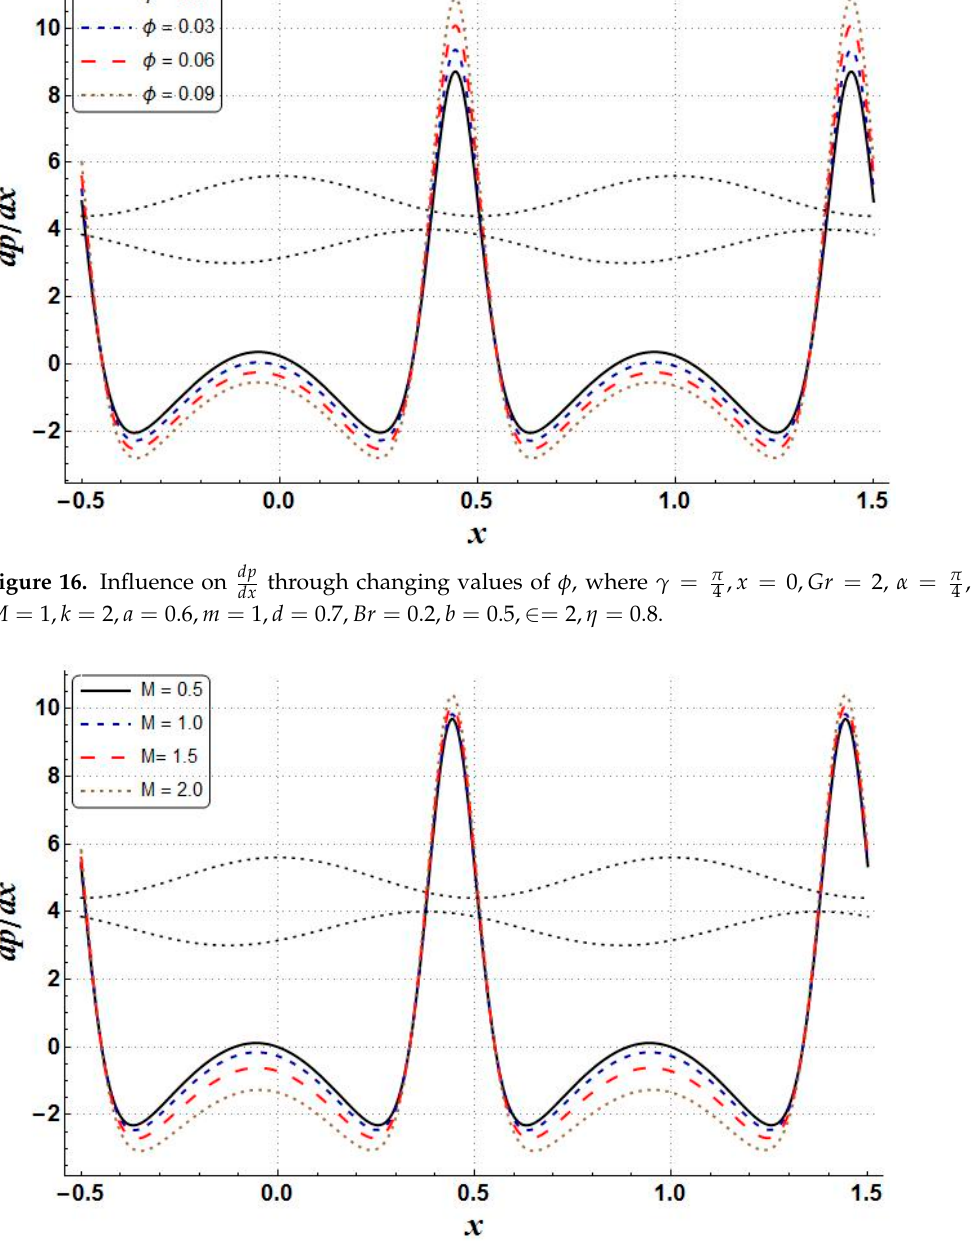
through changing values of M , where γ = π dx dx